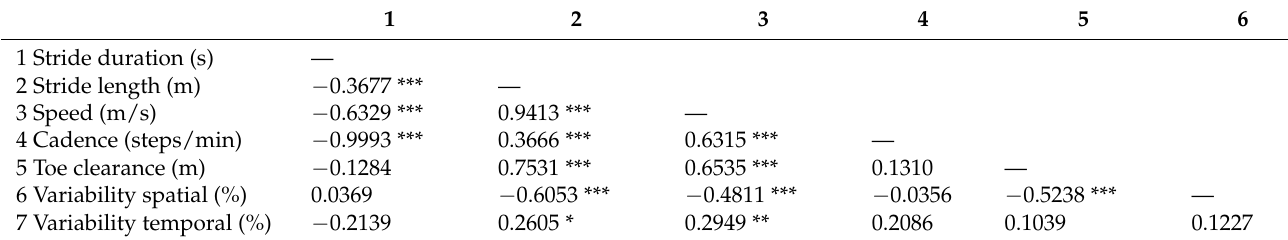
Table 1. Correlation Matrix: Spearman correlations between gait parameters.